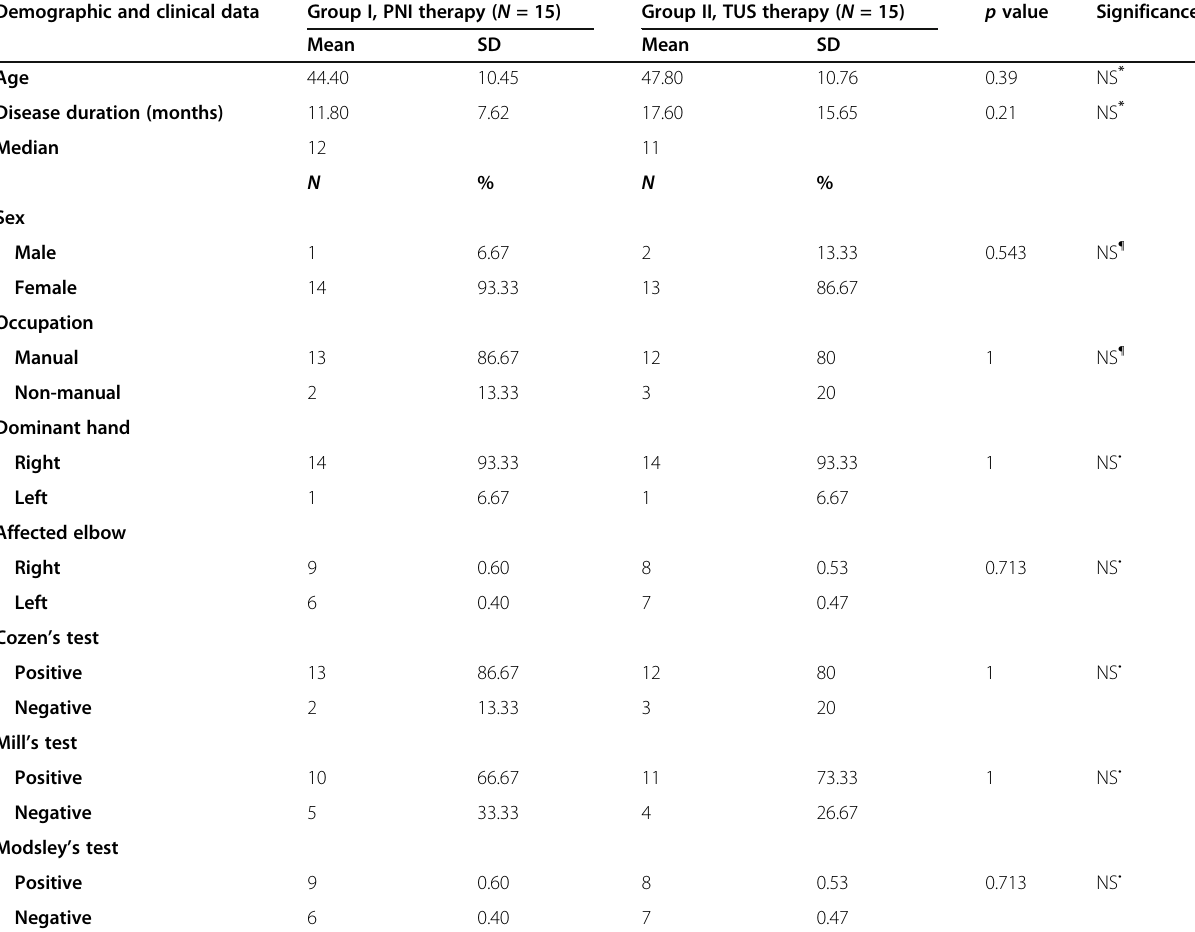
Table 1 Comparison of demographic and clinical data between both patients ’ groups Demographic and clinical data Group I, PNI therapy ( N =